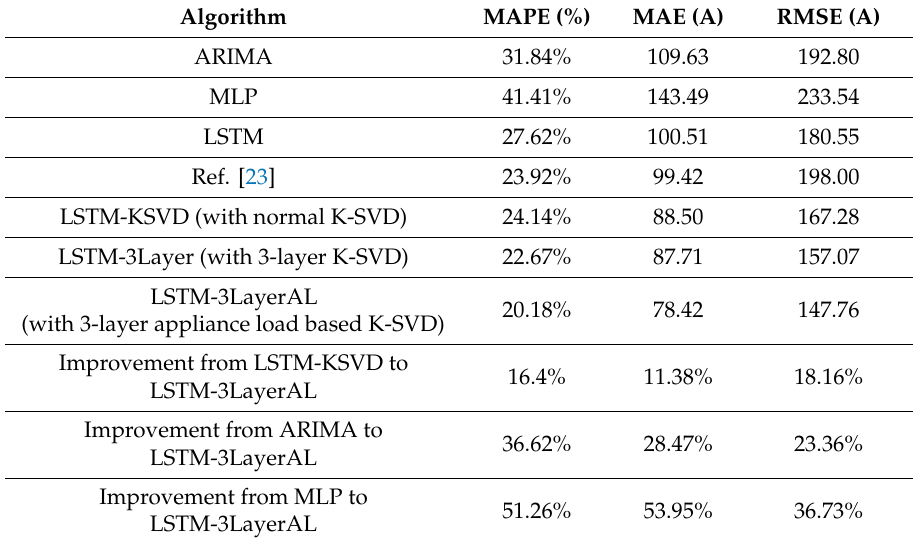
Table 2. Forecasting performance comparison between proposed method and existing algorithms.